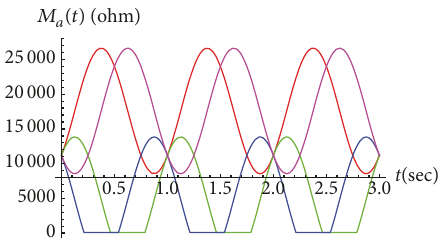
Figure 23: 𝑀 𝑎 (𝑡) of the fractional order memristor under the sinusoidal input with 𝐼 𝑚 < 0 : 𝜃 = 45 ∘ (red), 𝜃 = 135 ∘ (green), 𝜃 = 225 ∘ (blue), and 𝜃 = 315 ∘